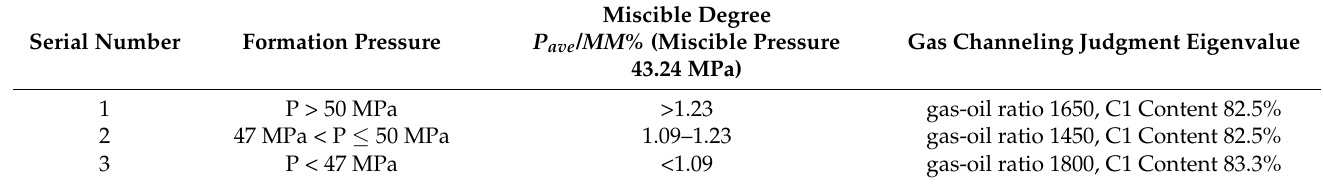
Table 4. Criteria for gas